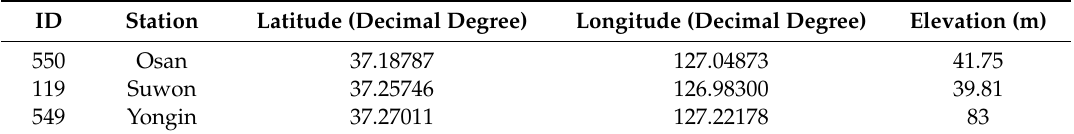
Table 1. Characteristics of the selected weather